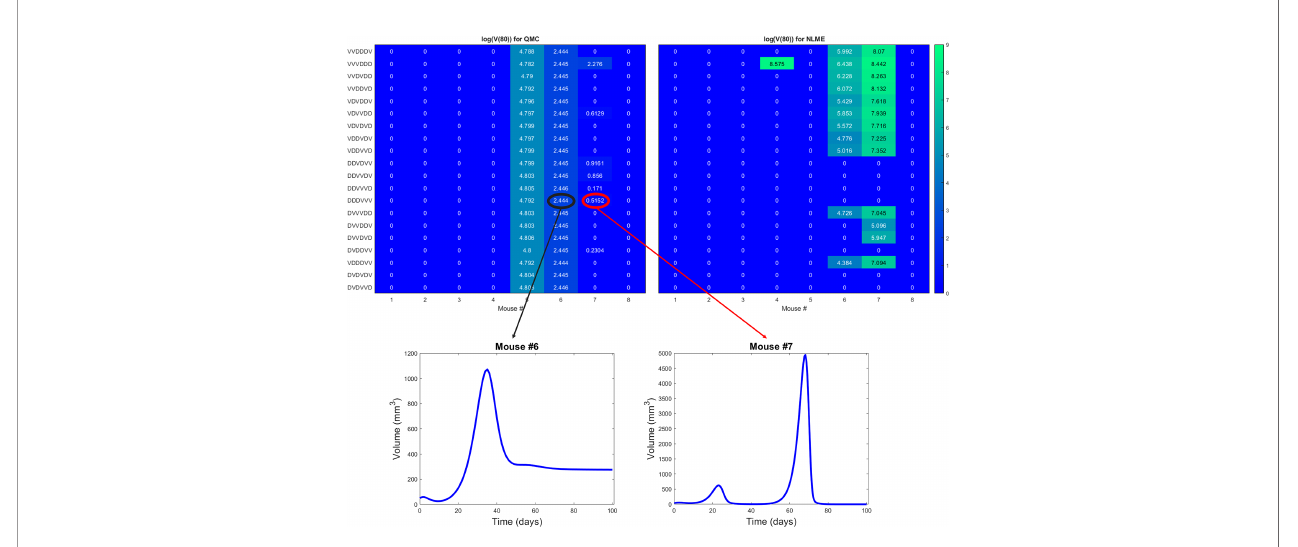
FIGURE 8 | Heatmaps showing the log of the tumor volume measured at 80 days, at the high DC (50% greater than experimental dose), low OV (50% lower than experimental dose) region of dosing space. Left shows predictions if parameters are fi t using QMC, and right shows NLME predictions. Inserts show time course of predicted treatment response for Mouse 6 and 7 to the optimal-for-the-average protocol of